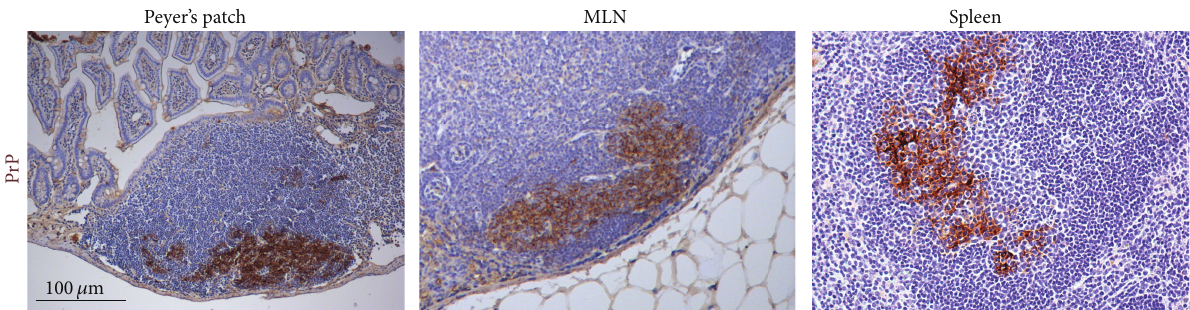
Figure2:Stromal-derivedfolliculardendriticcellsareimportantsitesofprionaccumulationandreplicationintheBcellfolliclesofsecondary lymphoid tissues. Detection of high levels of abnormally folded, disease-specific prion protein (PrP, brown) in Peyer’s patches, mesenteric lymph nodes (MLN), and spleen of a mouse infected with ME7 scrapie prions. Sections are counterstained with haematoxylin